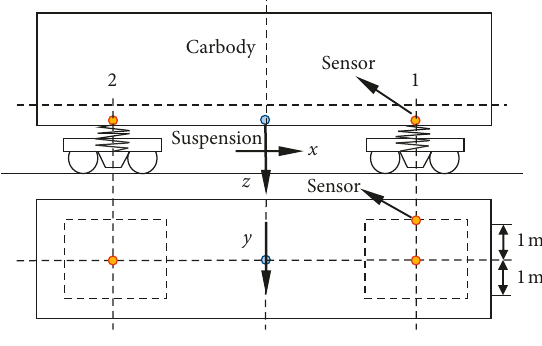
Figure 15: Sensor